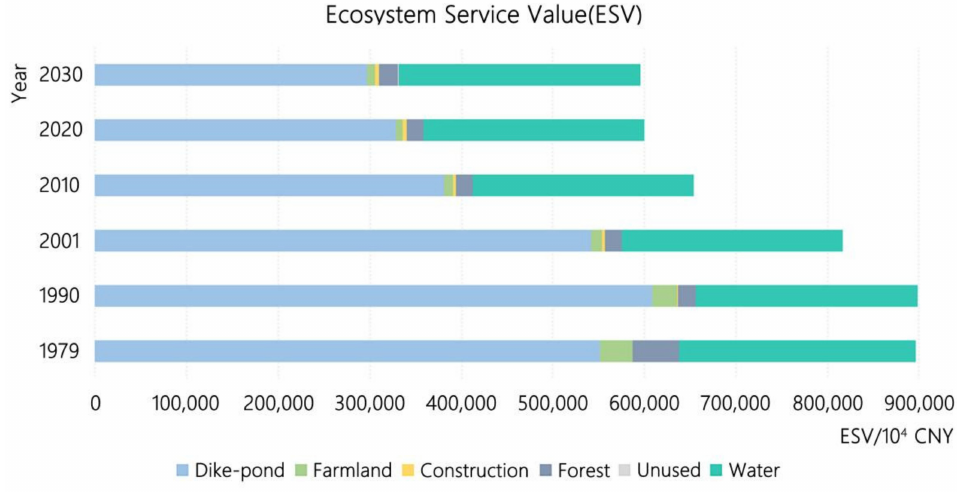
Figure 8. ESV of the study area from 1979 to